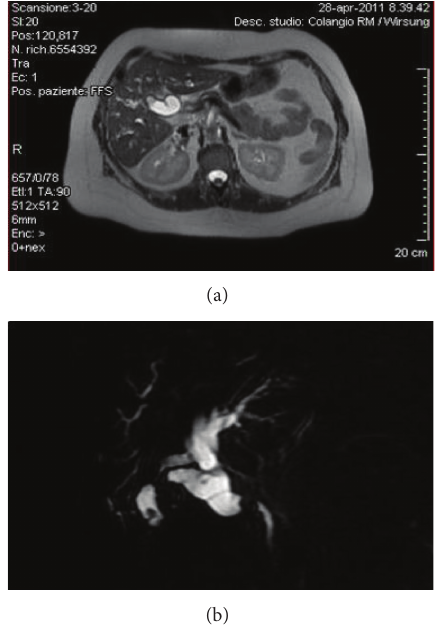
Figure 1: (a) MRI showing a sclero-atrophic cholecystitis with an endoluminal stone. (b) Cholangiographic reconstruction showed an absence of signal in the pre-papillary tract of CBD, with intrahepatic duct dilatation of the left lobe of the liver. Figure 2: (a) Transverse colonic loop (blue arrow) tightly adherent to cystic duct (yellow arrow) gallbladder (light blue arrow). (b) Macroscopic appearance of the removal cholecystocolonic